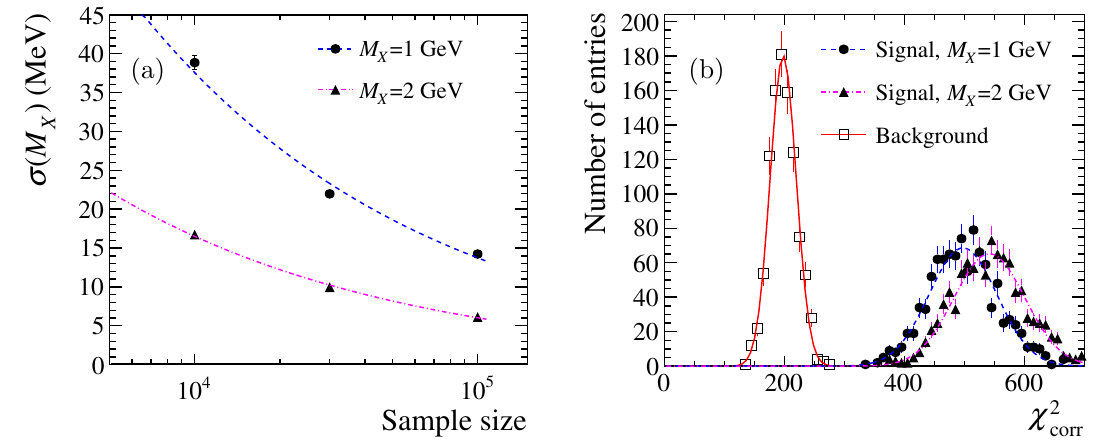
Figure 11 . (a) Mass resolutions for M X = 1 GeV and M X = 2 GeV cases as a function of sample size. Smooth lines are the result of the (cid:12)ts with the function proportional to inverse square root of the sample size. (b) Distributions of the test statistic (cid:31) 2 for background samples and signal with corr M X = 1 GeV and M X = 2 GeV. Smooth lines are results of the Gaussian